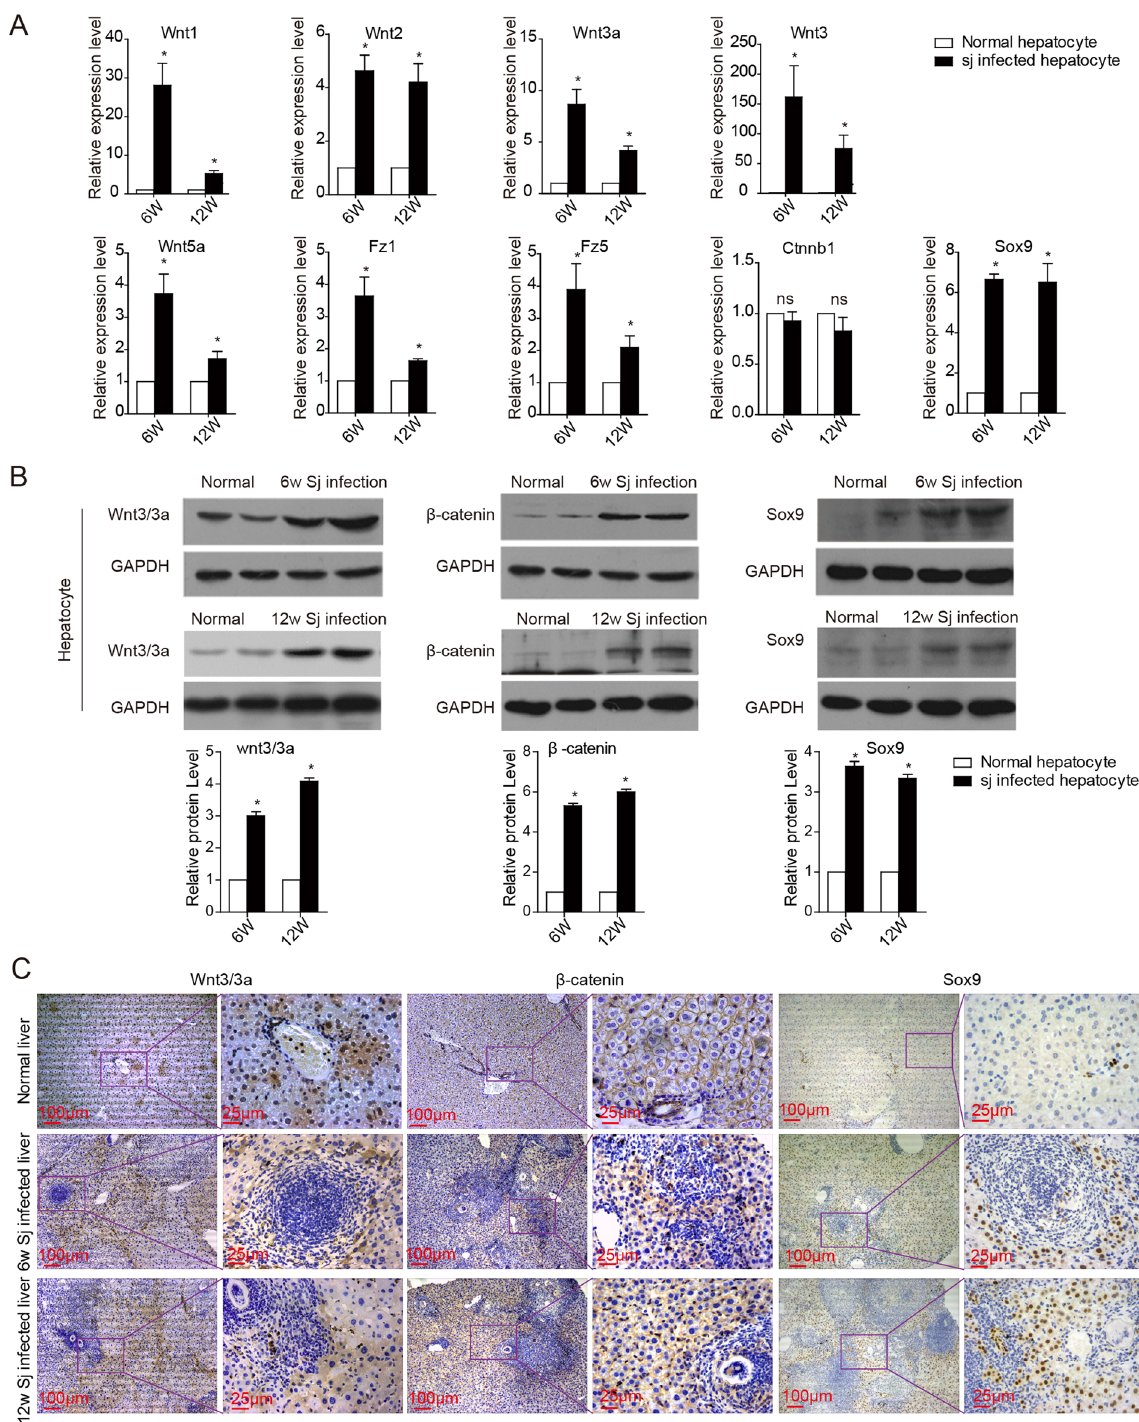
Figure 1. S. japonicum infection accelerates the expression of Wnt signalling-related molecules in hepatocytes. Primary hepatocytes were isolated from normal mice and mice after 6 and 12 weeks of S. japonicum infection. ( A ) Real-time PCR analysis of Wnt1, Wnt2, Wnt3, Wnt3a (canonical molecules), and Wnt5a (noncanonical); Fz1 and Fz5 (receptors of Wnt); and the Wnt signalling target genes β -catenin and Sox9. ( B ) The expression of Wnt3/3a, β -catenin, and Sox9 was detected by western blotting 6 or 12 weeks after infection. ( C ) Liver sections were immunohistochemically stained for Wnt3/3a, β -catenin, and Sox9. Sj, S. japonicum . Scale bar, 100 μ m (left) and 25 μ m (right). Data represent the mean ± SEM; n = 5 ( * P < 0.05). ns, no